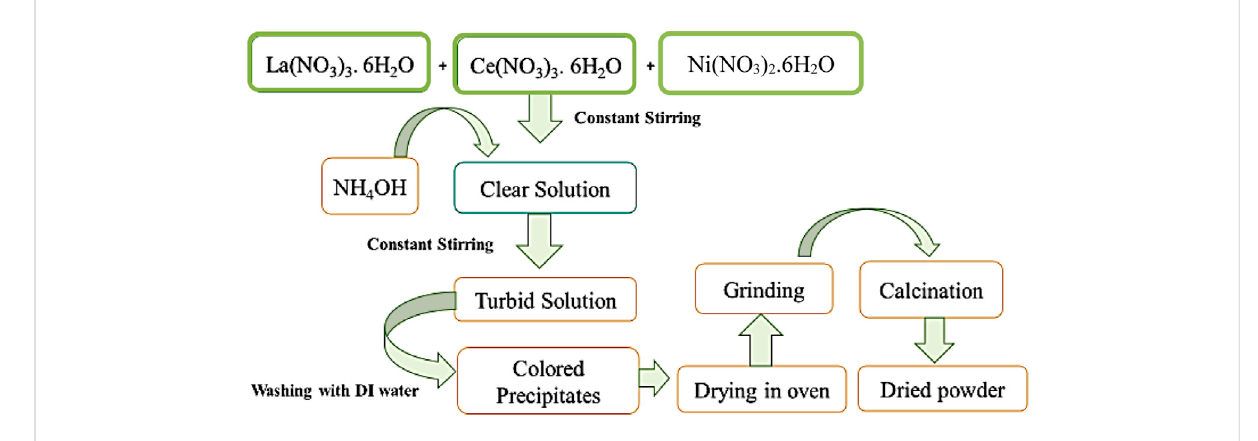
FIGURE 1 Flowsheet diagram for the synthesis of pure and nickel-doped